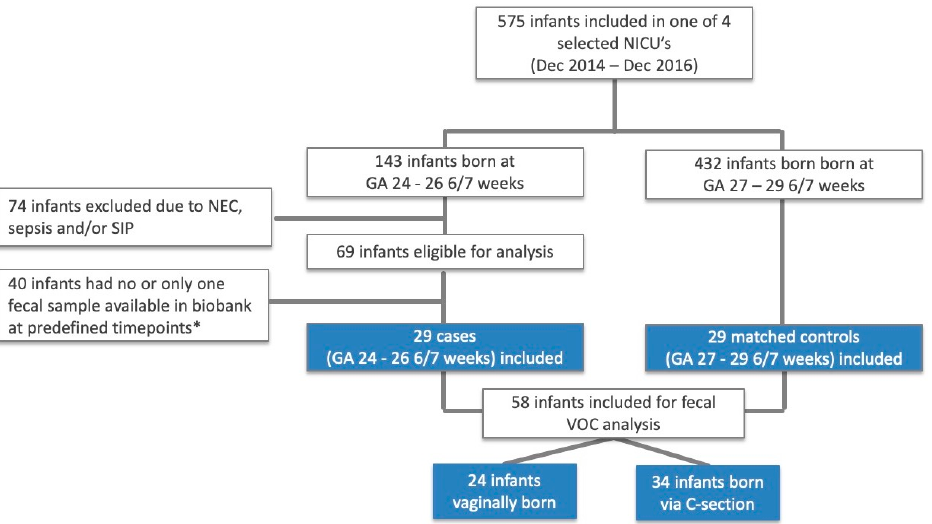
Figure 2. Flow of participants. Abbreviations : GA, gestational age. * Day of life 7 (+/ − 2 days), 14 (+/ − 2 days), and 21 (+/ − 2 days).